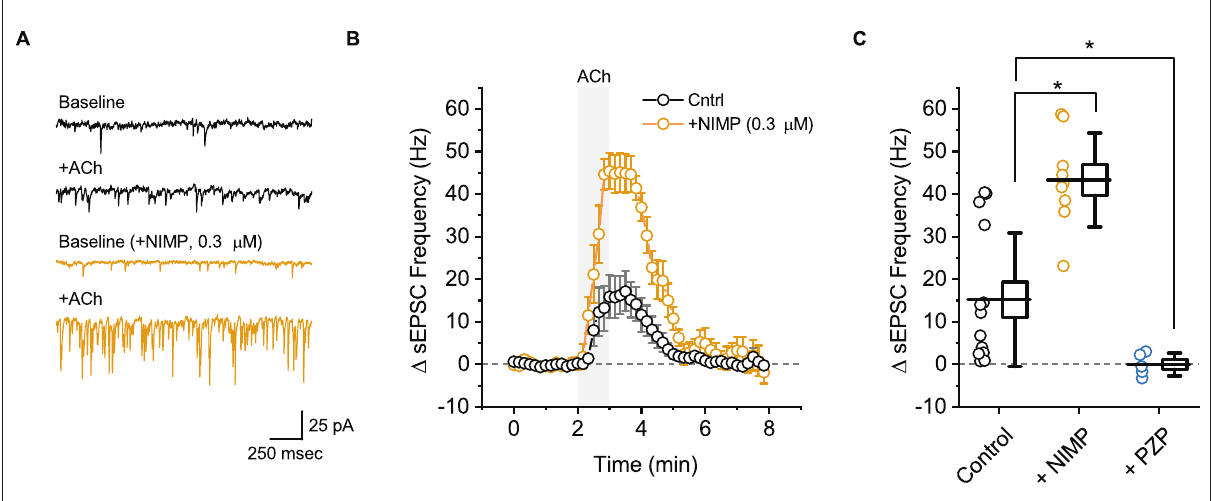
FIGURE2 ACh-induced increases in sEPSC frequency in BLA pyramidal neurons can be used to quantify the effects of central AChE inhibition. (A) Top two traces (black) illustrate the effect of bath applied ACh (100 µ M for 1 min) on sEPSCs as observed in a representative BLA pyramidal neuron voltage clamped at − 70 mV in control conditions. Next two traces (orange) are representative of data obtained when an identical experiment was performed in a slice that was preincubated in 0.3 µ M NIMP. (B) ACh-induced change in sEPSC frequency over time as recorded in neurons from control slices ( n = 14, open black circles) and from neurons in slices preincubated in 0.3 µ M NIMP (open orange circles, n = 9). ACh (100 µ M) was bath applied from 2 to 3 min (gray shaded area). Error bars represent the SEM. (C) Summary data illustrating the ACh-induced change in sEPSC frequency, observed from 3 to 4 min as plotted in panel (B) , for each cell in the control and NIMP datasets (open black and orange circles respectively). Blue circles (PZP) illustrate the effect of ACh on sEPSC frequency in neurons from control slices, as observed in the